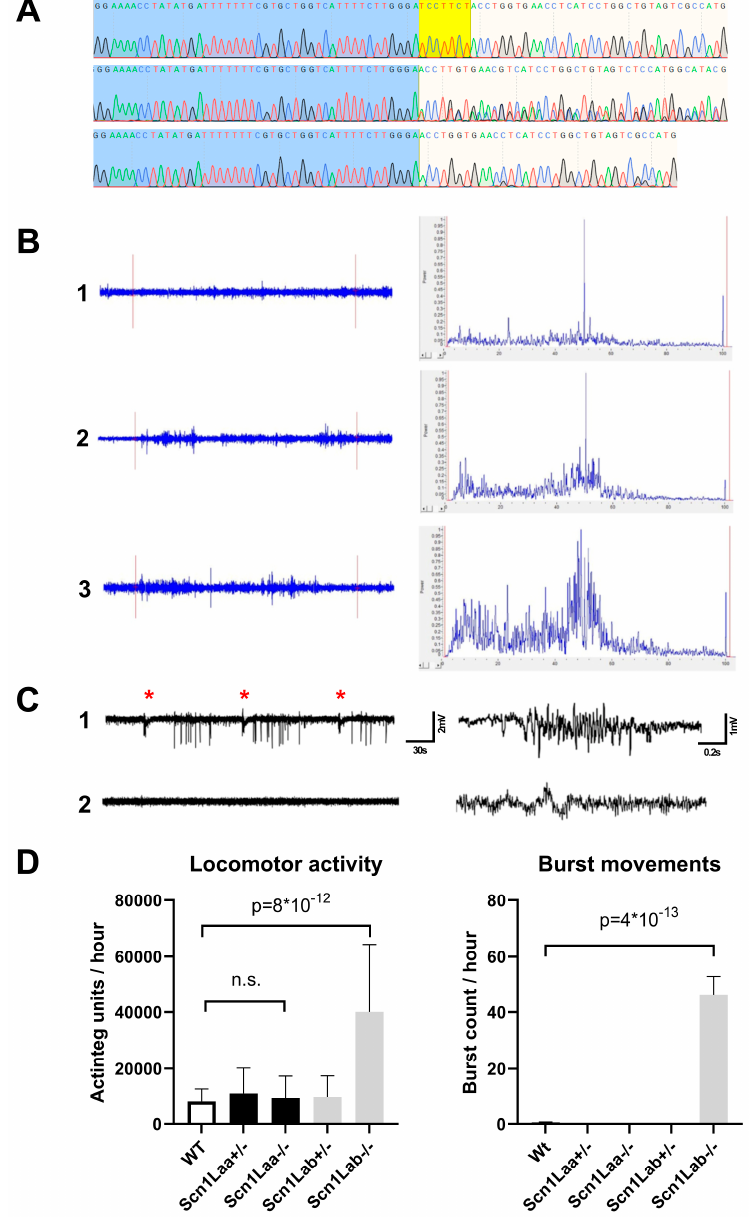
Figure 3. Genotype and phenotype of scn1laa − / − ( A ) Sanger trace showing wt (top), heterozygous 7 bp deletion (middle) and homozygous 7 bp deletion (bottom) strains generated for this study. The deletion is highlighted in yellow. ( B ) Local field potential (LFP) recordings of the zebrafish brain showing baseline activity of wildtype animals (1) and spontaneous epileptiform activity in scn1Laa − / − animals (2,3). Per recording, the region marked between red lines was used to generate power spectra after fast-Fourier analysis highlighting an enrichment of both low- and high-frequency signals during epileptiform events. ( C ) LFP recordings after light stimuli presented at each asterisk for scn1laa − / − (1) and wildtype (2) animals. Detailed traces are shown on the right side. ( D ) Locomotor profiles of scn1laa KO strains compared to wildtype and scn1lab KO strains [5]. n = 12 animals were used per group. A p value higher than 0.01 was considered not significant